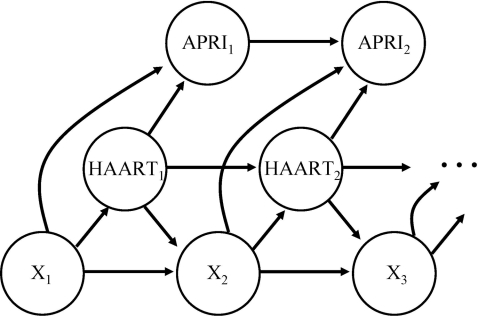
Postulated causal diagram.A directed acyclic graph of the relationship between HAART exposure and APRI over time, where potentially confounding variables such as, for example, CD4+ T-cell counts, are represented by X. The Generalized Propensity Score permits unbiased estimation of the direct (or cross-sectional) effect, α, of most recent HAART intake on the response.